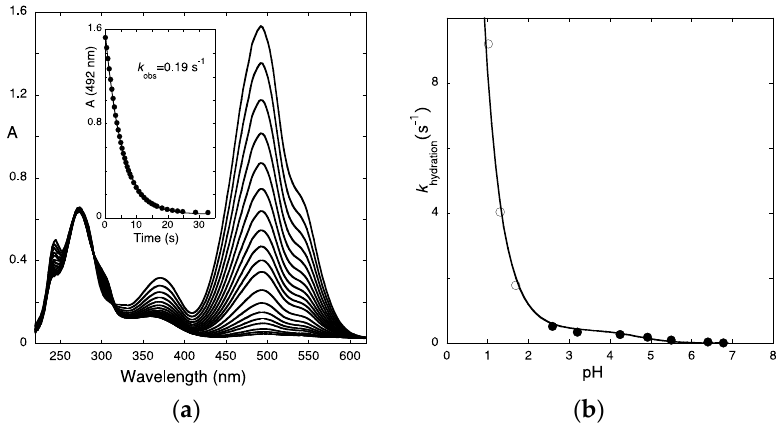
Figure 5. ( a ) Spectral variations observed upon a direct pH jump from 1 to 4.9; ( b ) pH dependence of the kinetic process controlled by the hydration reaction followed by stopped flow: ( • ) direct pH jumps; Fitting was achieved with Equation (10) for p K a = 4.6; k h = 0.3 s − 1 ; k − h = 75 M − 1 · s − 1 . ( ◦ ) reverse pH jumps, fitting was achieved with Equation (17) which is coincident with Equation (10) within experimental error due to the low value of K t = 0.05, see below. With permission of RSC from ref. [15].